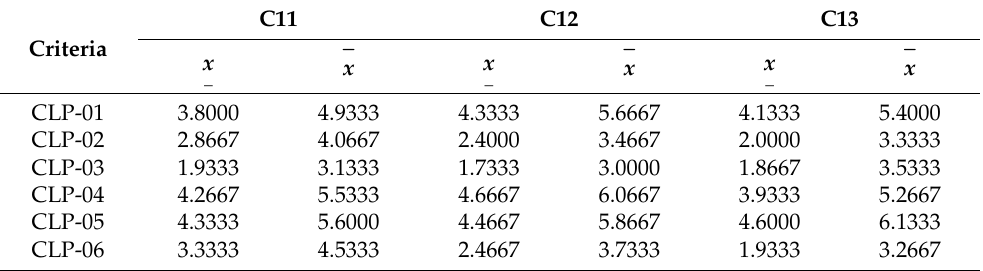
Table 11. The integrated grey decision matrix of C1